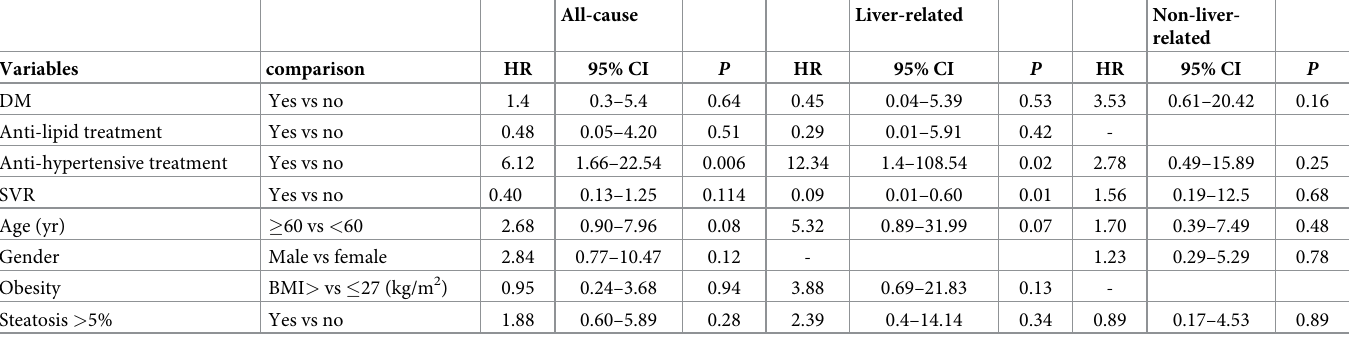
Table 4. Features Associated With Mortality in Mild Fibrotic Patients (fibrosis score 0–2) (N = 833) According to Cox Proportional Hazards Model:Results of Mul- tivariate Analyses.